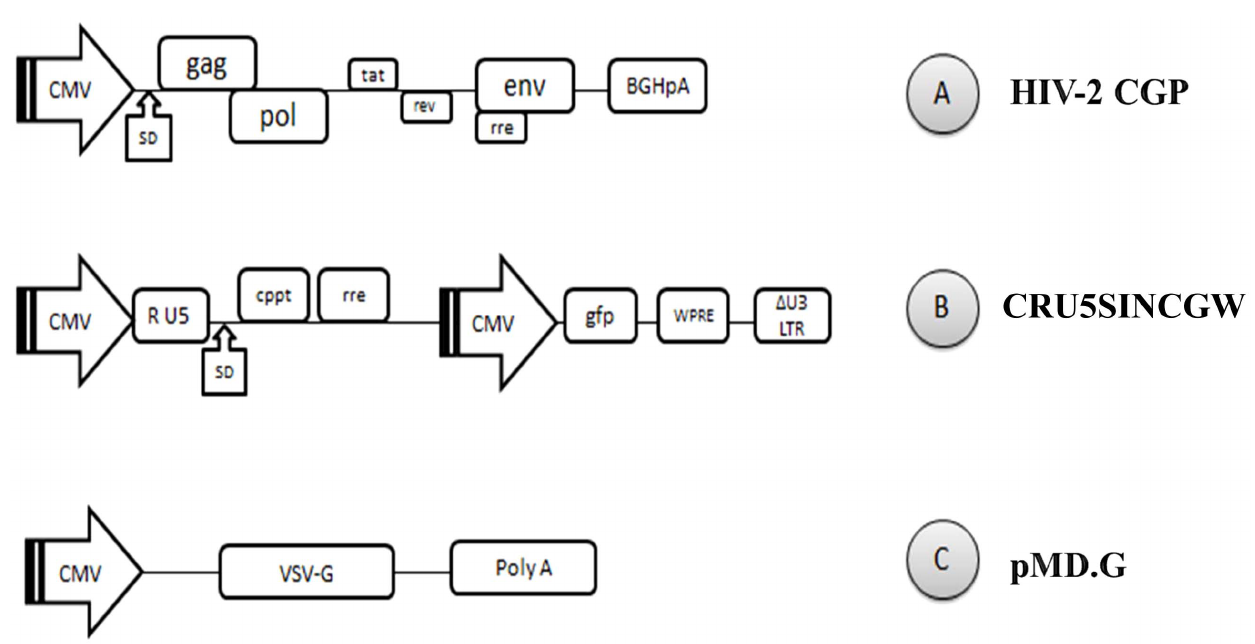
Figure 1. Vectors used for 293T cell transfection. A : HIV-2CGP, a CMV driven gag-pol expression construct. B : CRU5SINCGW, HIV-2 based minimal vector with a GFP expression cassette. C : pMD.G a plasmid coding for VSV envelope protein. CMV: human cytomegalovirus immediate early promoter; SD: splice donor site; rre: rev response element. BGHpA: bovine growth hormone polyadenylation signal. U3-R-U5; retroviral long terminal repeats. cppt; central polypurine tract. GFP; green fluorescence protein. WPRE; woodchuck hepatitis virus post-transcriptional regulatory element. VSV-G; vesicular stomatitis virus G protein. PolyA; polyadenylation site.